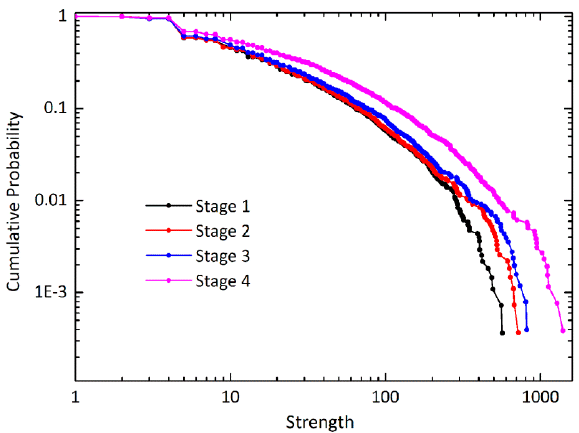
Figure 7. Cumulative probability of strength distribution.